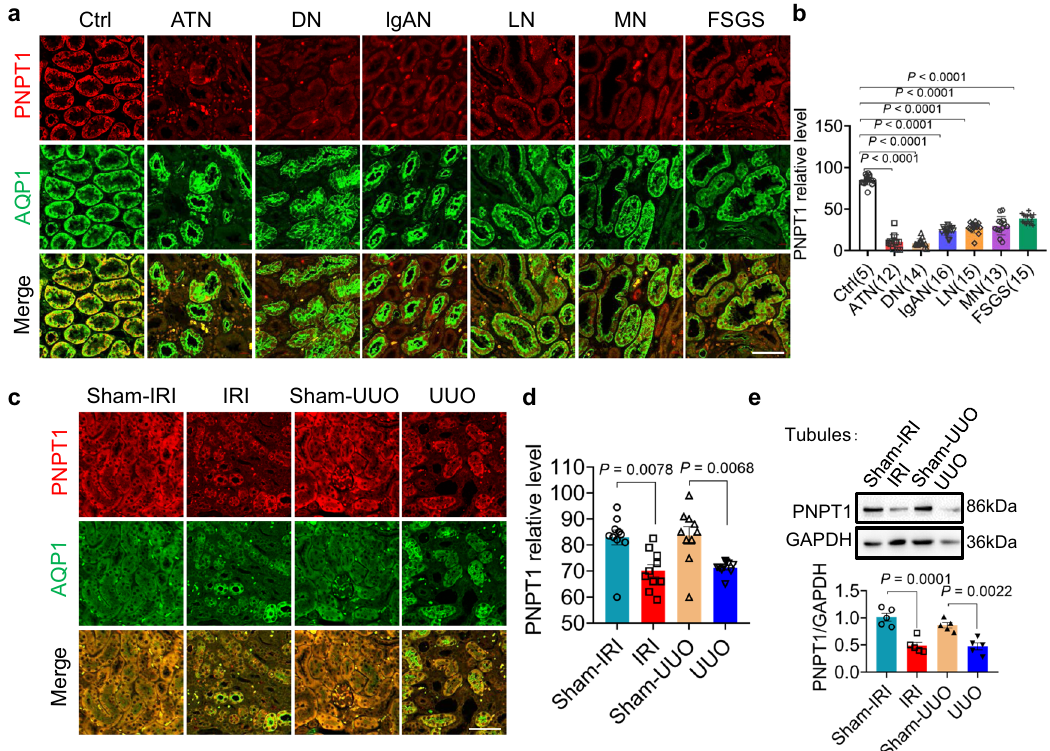
Fig. 2 | Reduction of PNPT1 in injured renal tubule. a Immunostaining of PNPT1 (red)inkidneysectionsfrompatientswithvariousdegreesofrenaltubularinjuryor from non-renal tubular injury controls as previously described in Fig. 1. Renal tubules were stained with anti-AQP1 antibody (green). b Quanti fi cation of renal tubular PNPT1 level in patients and controls. Renal tissue samples were from 85 patientsincludingATN(5malesand7females),DN(8malesand6females),IgAN(9 malesand7 females),LN (5males and 10females),MN (8malesand 5females)and FSGS(6malesand9females),aswellas5non-renaltubularinjurycontrols(3males and 2 females). Images of 10 randomly selected regions per sample were obtained